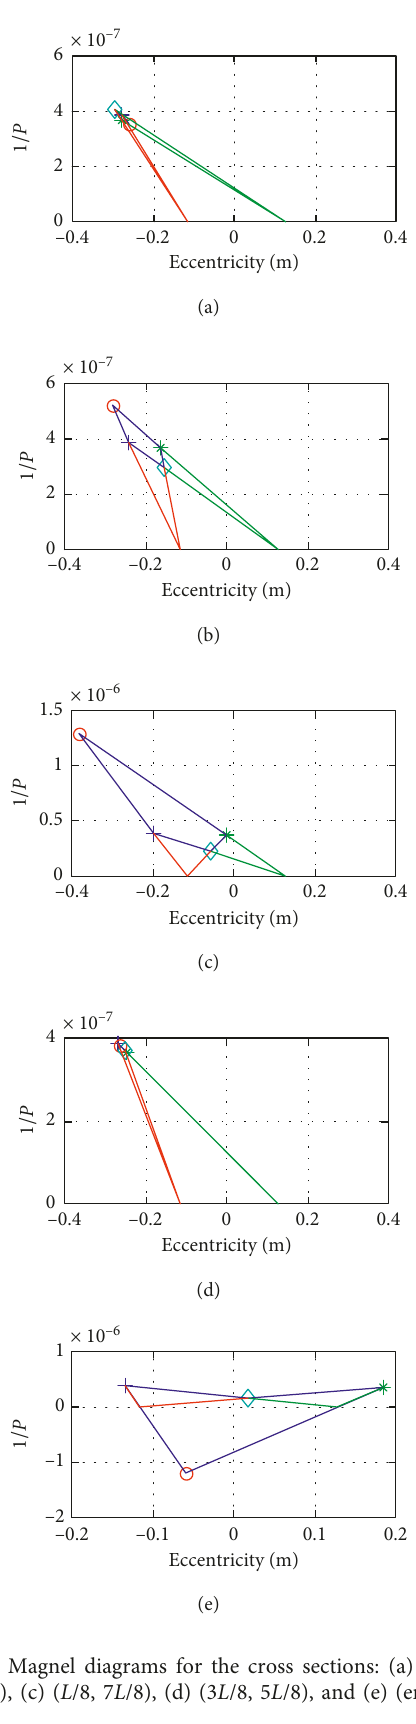
Figure 6: Magnel diagrams for the cross sections: (a) ( L /2), (b) ( L /4, 3 L /4), (c) ( L /8, 7 L /8), (d) (3 L /8, 5 L /8), and (e) (ends 0, L ).